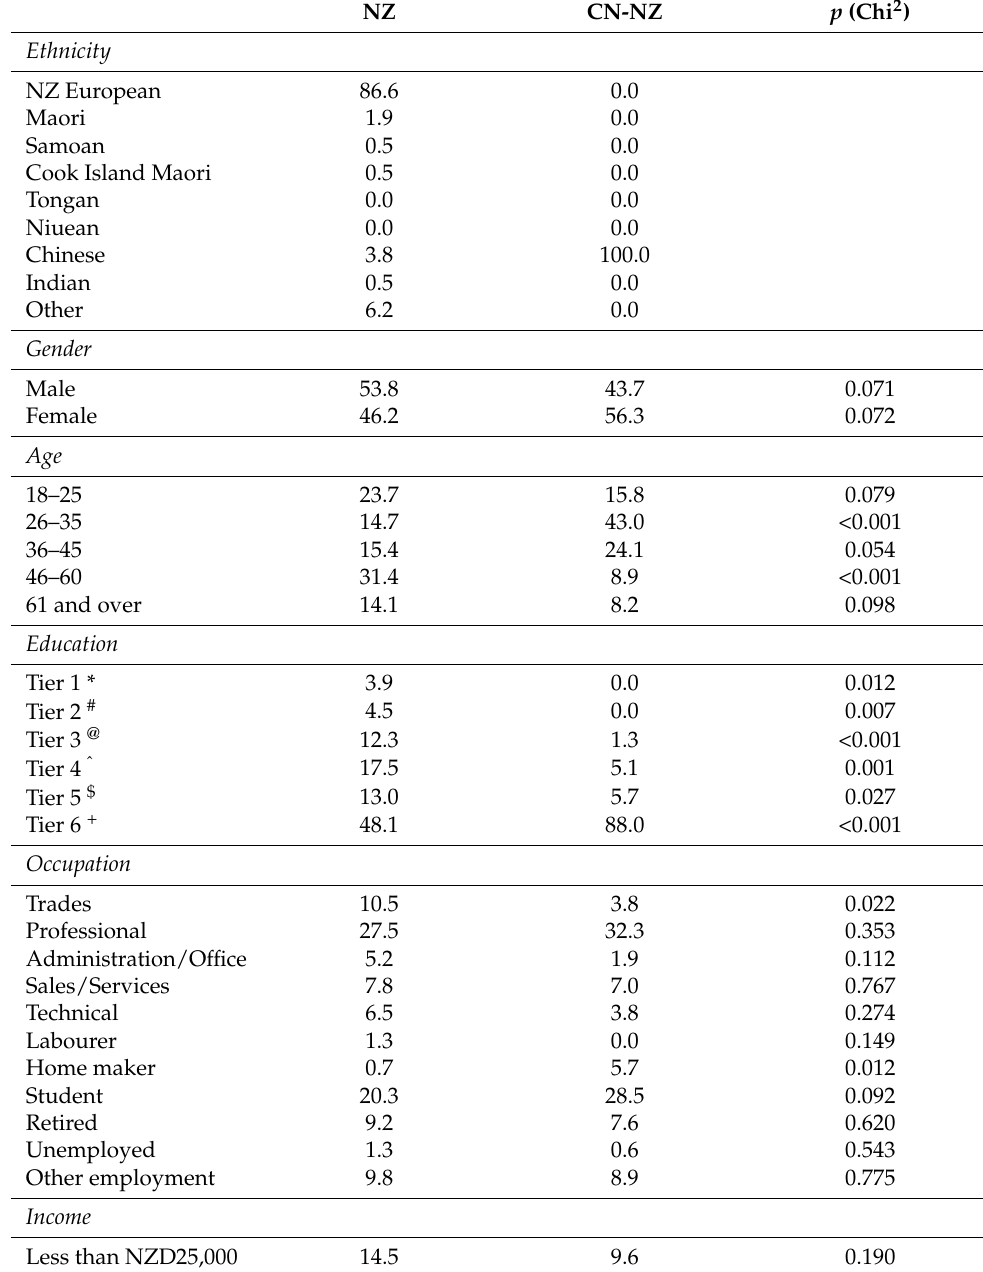
Table 1. Demographic characteristics of New Zealand and Chinese consumers in New Zealand